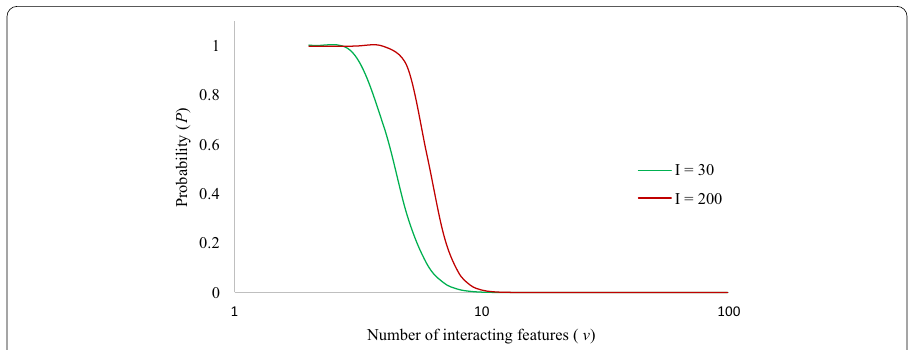
Fig. 4 Given s 3, the probability of grouping interacting features is decreasing with respect to the = increasing number of interacting features v over 30